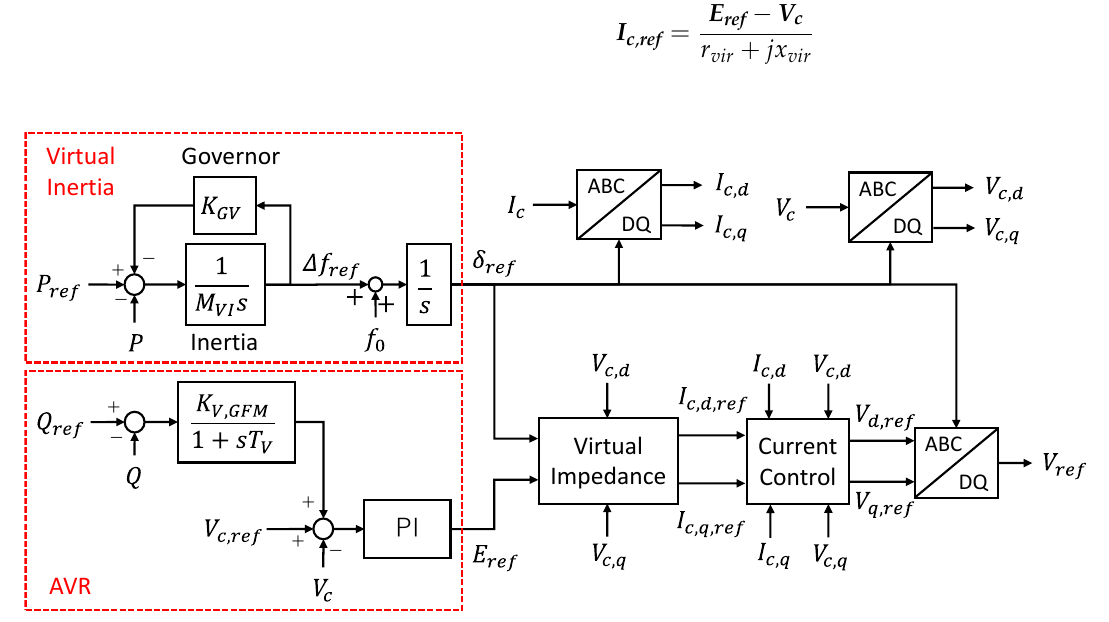
Figure 8. Controller model of the VI-GFM.